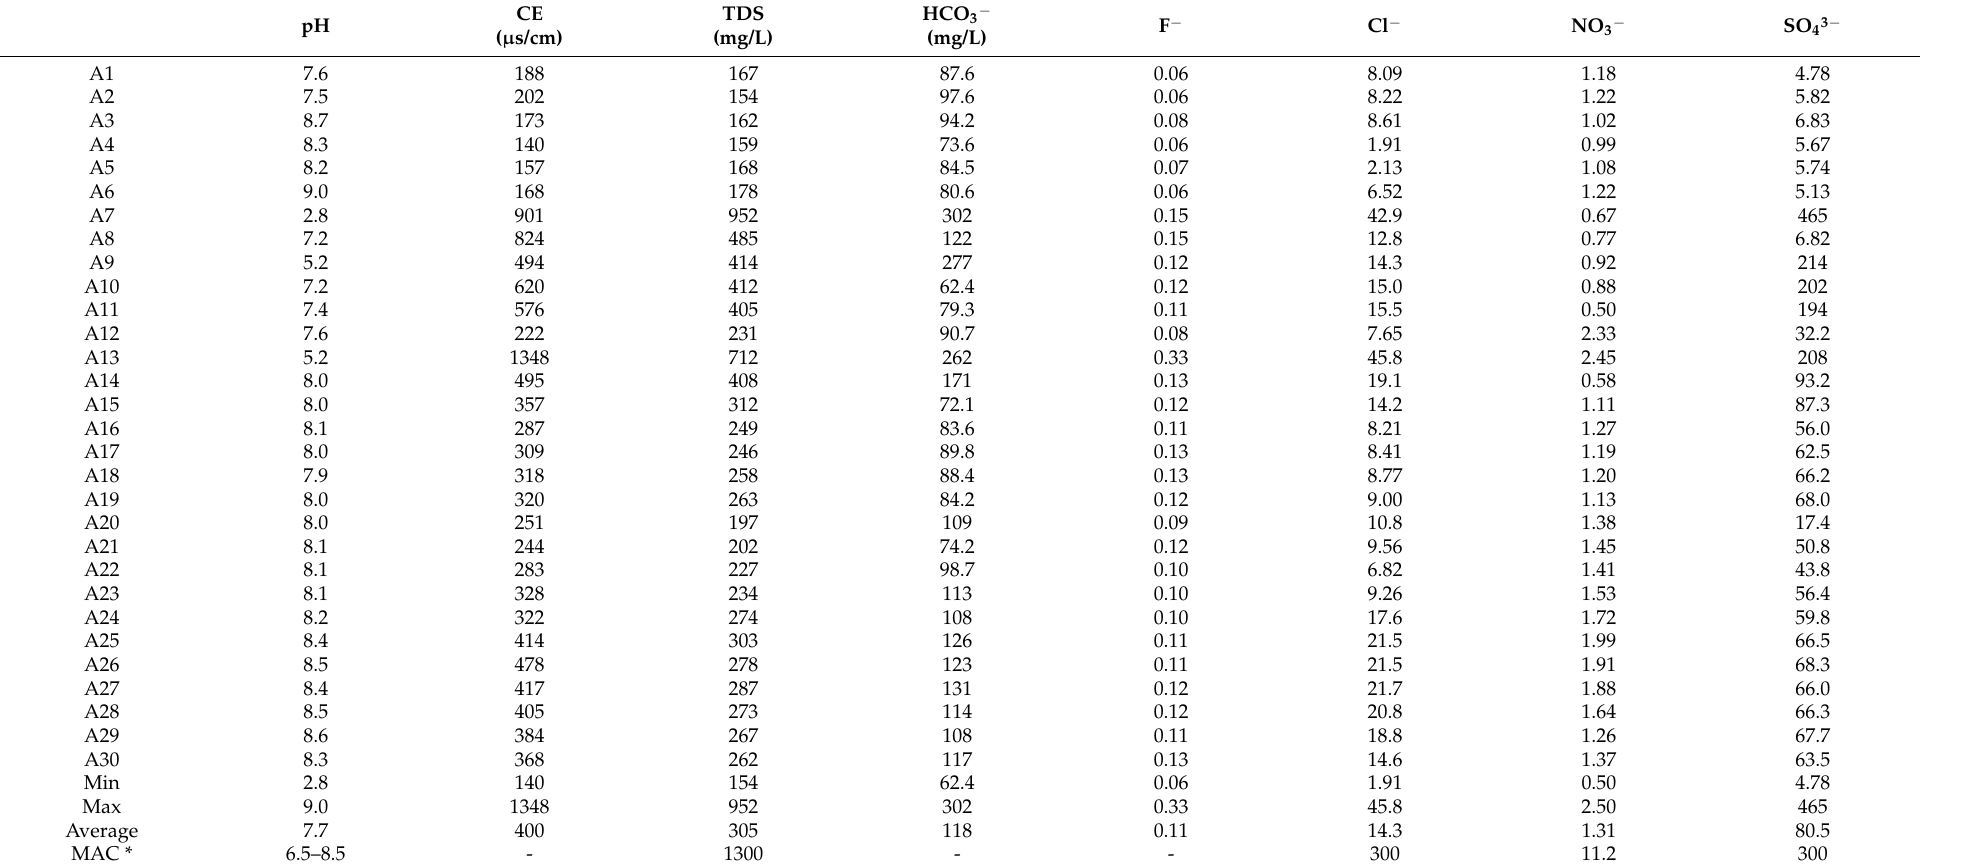
Table 3. Trend of spatial variation of the physico-chemical parameters analyzed in the Aries River water